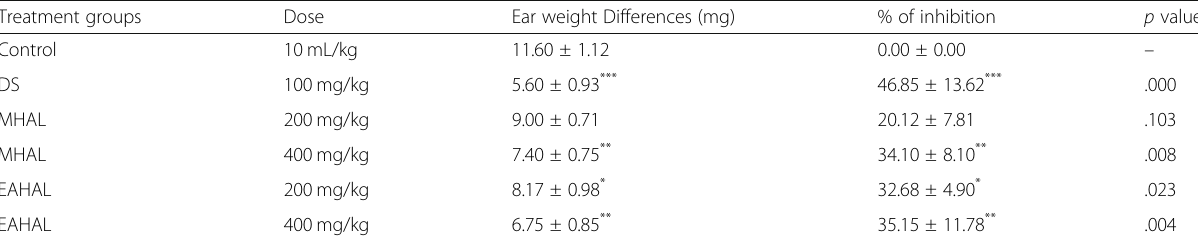
Table 2 Effect of standard and MHAL and EAHAL on Xylene induced ear edema test Treatment